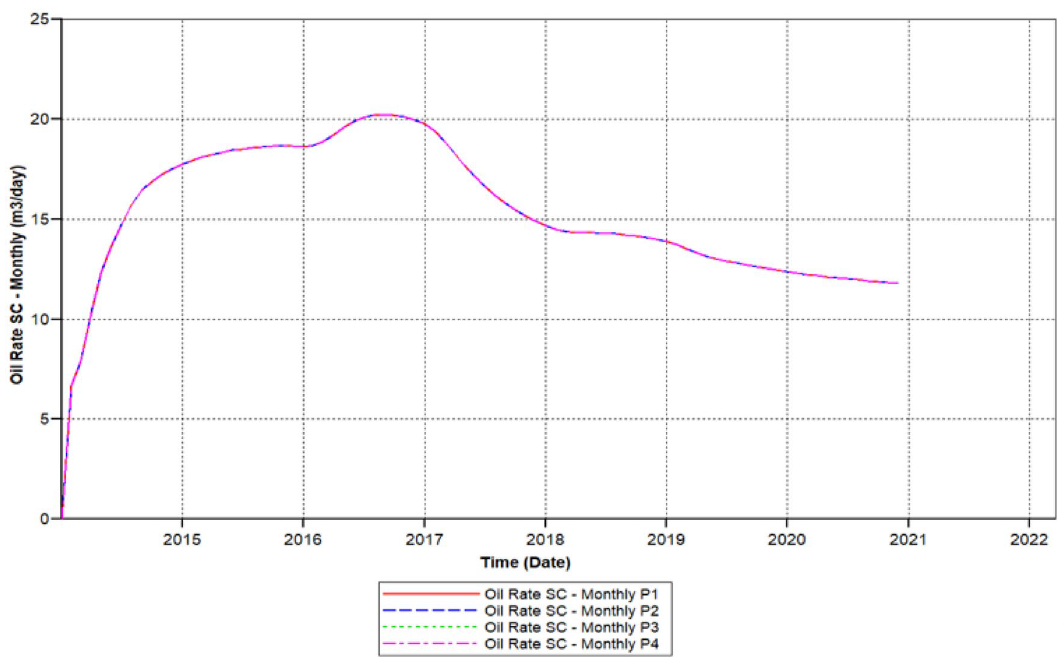
Figure 10. Shows the polymer sand plug model oil ratio CMG STARS 2017.10 URL: https:// www. cmgl.